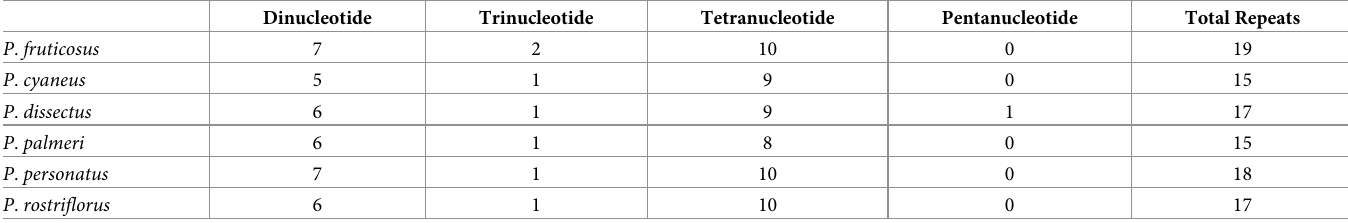
Table 4. Simple sequence repeats. The number of each type of simple sequence repeats (SSRs) identified in each plastome using the MISA webserver (http://misaweb. ipk-gatersleben.de/). Penstemon fruticosus is included in this study as a reference for the basal clade of Penstemon .